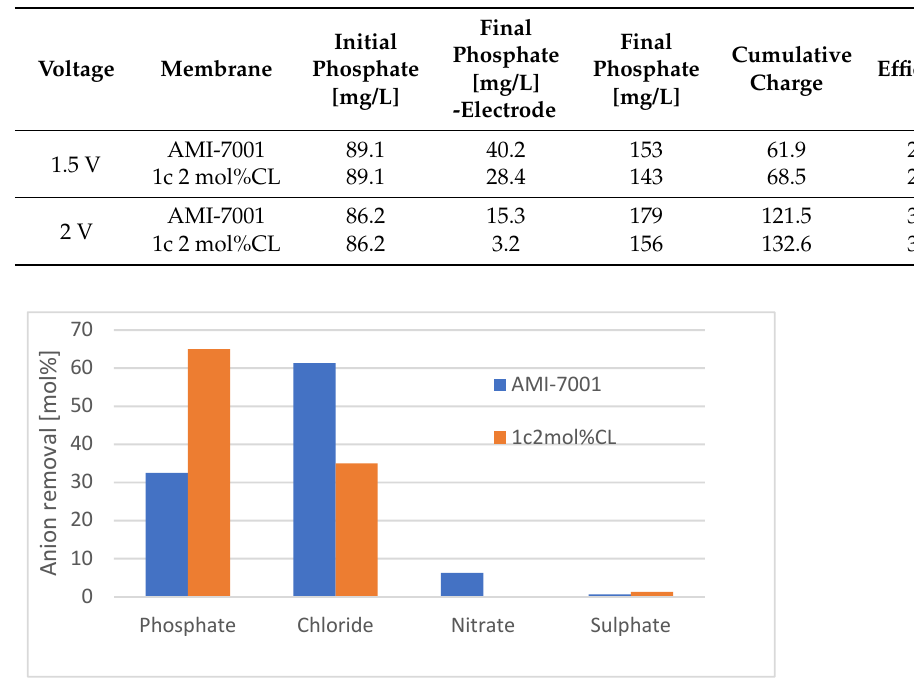
Figure 6. Selectivity of anion removal by the electrodialysis. Comparison of mol% removal of phos- phate, chloride, sulphate, and nitrate ions from aerated swine WW, AMI-7001 (blue); 1c 2mol%CL AEM (orange). AMI-7001 shows higher permeability to chloride anions and 1c 2mol%CL shows higher permeability to phosphate anions.